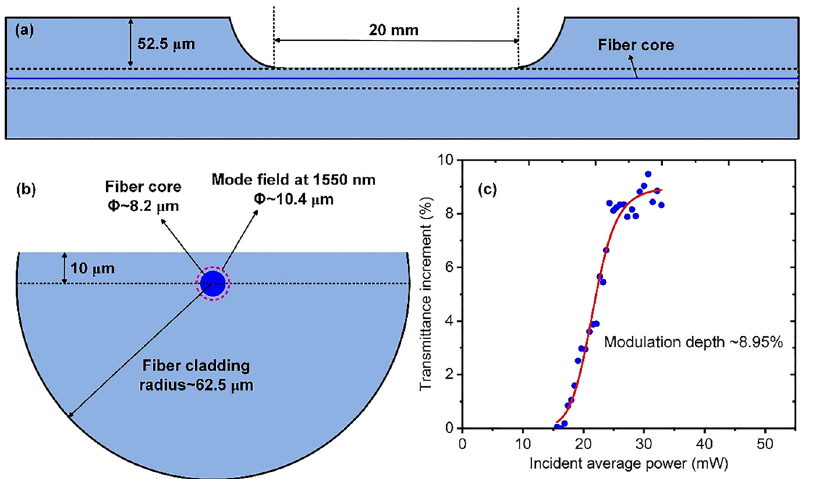
Figure 8: Schematic (a) side section and (b) cross-section of the DF. (c) Measured nonlinear absorbing characteristics of the BPQDs-coated